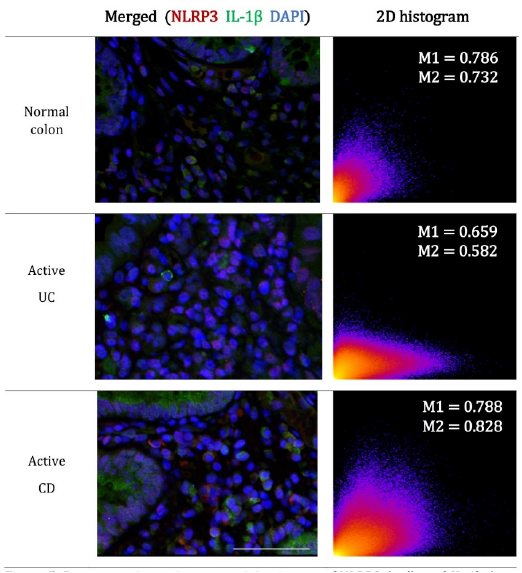
Figure 5. Representative co-immunostaining images of NLRP3 (red) and IL-1b (green) in normal colon and active UC and CD. Parrafin embedded colon biopsies were simultaneously stained with NLRP3 (ab16097, Abcam, Cambridge, MA, USA) and IL-1 β (ab9722, Abcam, Cambridge, MA, USA) and visualized using AlexaFluor 647 conjugated mouse anti-goat (red) and AlexaFluor 555 conjugated rabbit anti-goat (green) respectively. Nuclei were stained with 4’,6-diamidino-2-phenylindole (DAPI, blue). The 2D histogram visualizes the overall relationship of channel intensities for homologous pixels. The coordinates of the scattergram are the channel (CH) intensities of NLRP3 (red-CH1-x) and IL-1 β (green-CH2-y) within each pixel. The value at each location indicates the incidence of the combination. Scale bar = 50 μ m for 400× magnification.